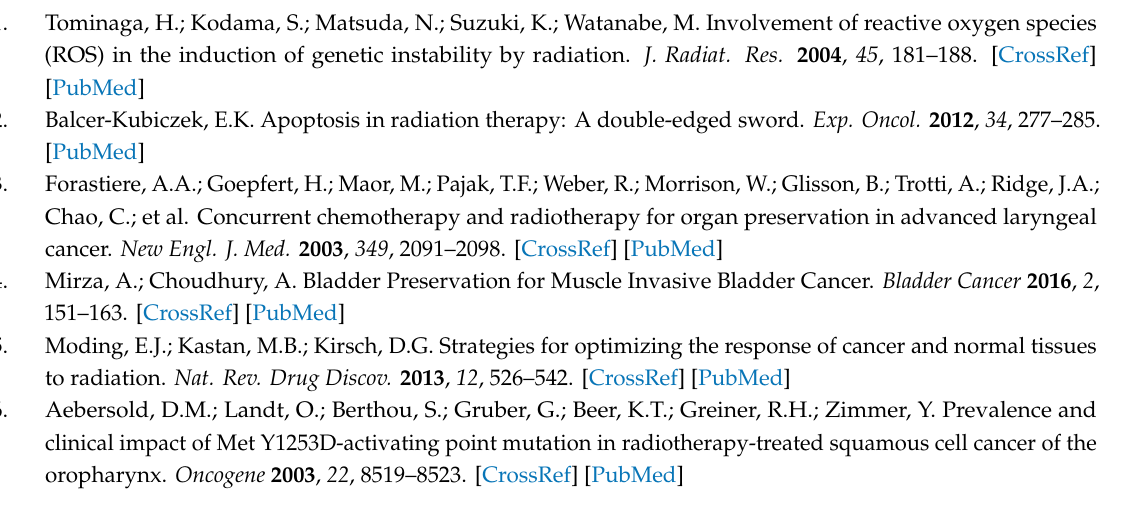
Figure S1: Analysis of Annexin V / PI double staining. Figure S2: The e ff ect of CGN and / or IR in normal cell line, MCF10A. Figure S3: Caspase-3 activity measured by western blot. Figure S4: Cell viability during the Matrigel chemoinvasion assay. Figure S5: Gene expression profiles after IR and CGN treatments. Figure S6: Immunofluorescence staining of siRNA-mediated knockdown of RacGAP1 in MDA-MB-231cells. Figure S7: Uncropped scans of western